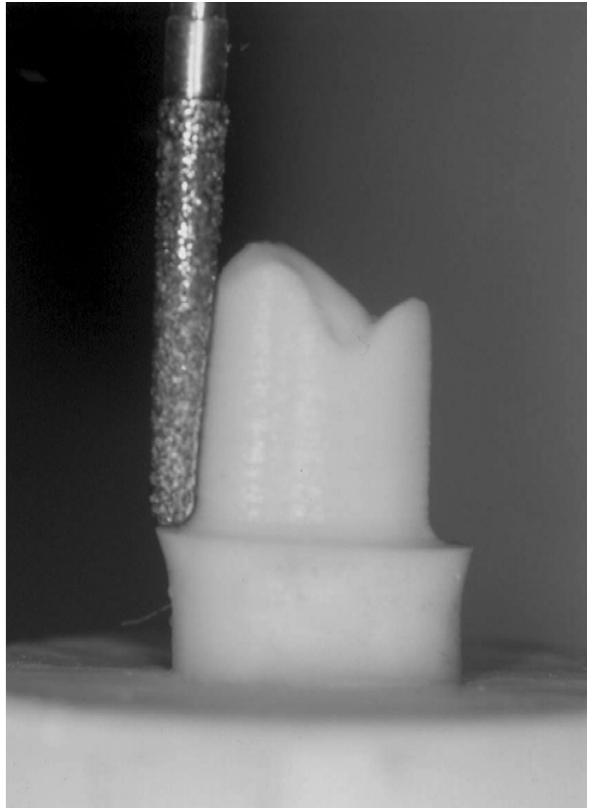
FIGURE 1- Tooth preparation